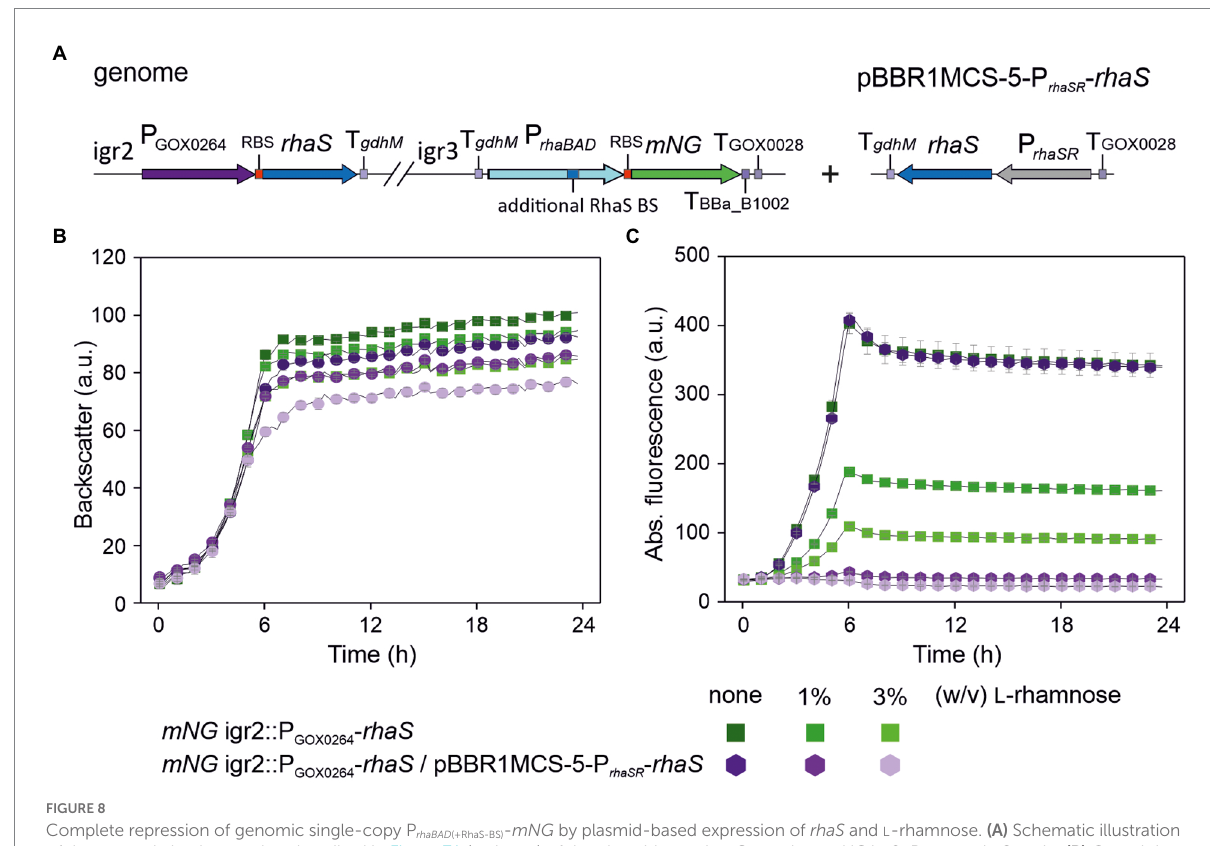
FIGURE 8 Complete repression of genomic single-copy P rhaBAD (+RhaS-BS) - mNG by plasmid-based expression of rhaS and l -rhamnose. (A) Schematic illustration of the genomic background as described in Figure 7A (variant a) of the plasmid-carrying G. oxydans mNG igr2::P GOX0264 - rhaS strain. (B) Growth in d -mannitol medium according to backscatter and (C) absolute mNG fluorescence in BioLector cultivations. For comparison, the plasmid-free strain with only the single-copy rhaS in igr2 was included in the BioLector run. l -Rhamnose was supplemented as indicated. Data represent mean values and standard deviation from three technical replicates of one clone ( mNG igr2::P GOX0264 - rhaS /pBBR1-MCS-5-P rhaSR - rhaS ) and two clones ( mNG igr2::P GOX0264 - rhaS ). BioLector settings: backscatter gain 20, fluorescence gain